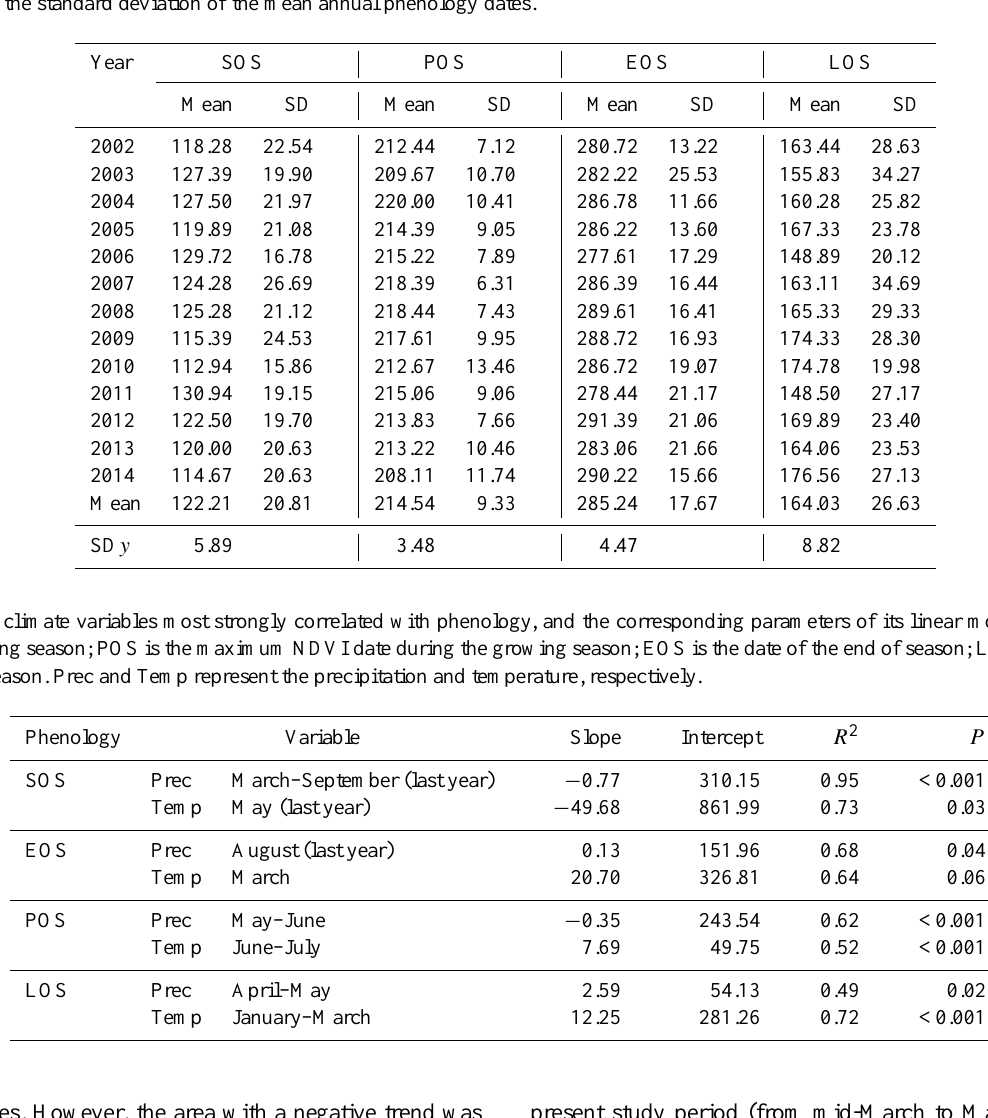
Table 3. Annual mean and standard deviation (SD) of phenological stages at 18 meteorological stations during 2002–2014. The units are day of year (DOY); SOS, POS, EOS and LOS are the start, peak, end and length of the growing season; Mean is the mean value of the phenology dates; SD y is the standard deviation of the mean annual phenology dates.